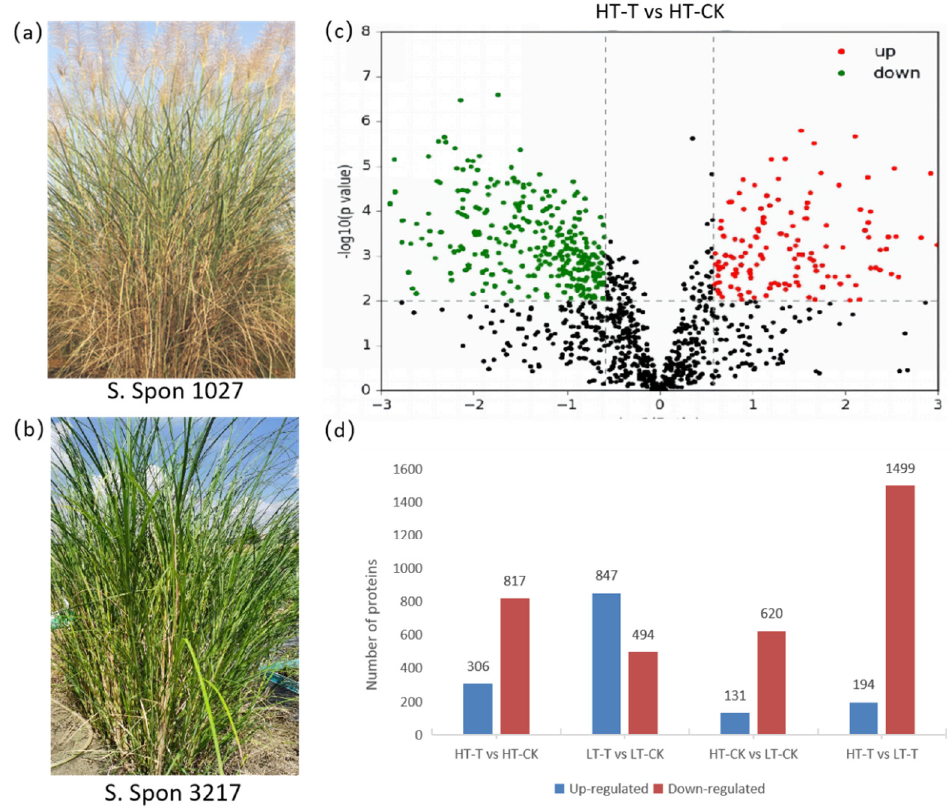
Figure 2. Phenotypes of two S. spontaneum genotypes for proteomics analysis and differentially abundant proteins from all comparison groups. ( a ) Phenotype of S. spontaneum 1027 with high tolerance to cold. ( b ) Phenotype of S. spontaneum 3217 with low tolerance to cold. ( c ) Volcano map of differentially abundant proteins from HT-T vs. HT-CK comparison. Red dots indicate upregulated (multiple of variation > 1.2, p < 0.05) proteins, green dots indicate downregulated (multiple of variation < 0.833, p < 0.05) proteins, and black dots indicate non-differentially expressed proteins. ( d ) Comparison of DAPs based on genotypes and treatments. Change ratio = 1.5 and p = 0.01 were selected as the differential protein threshold.